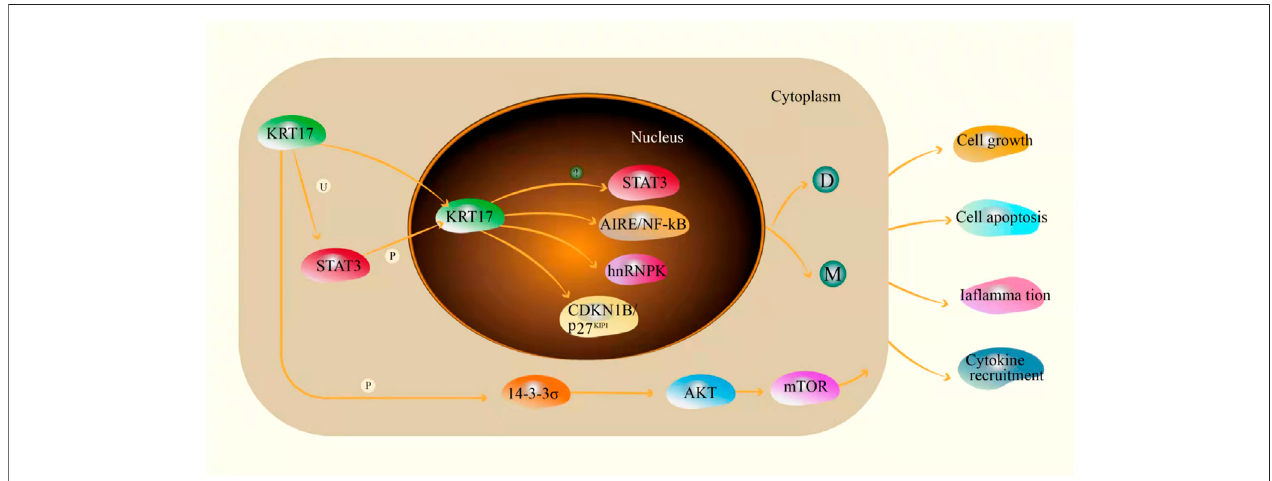
FIGURE 2 | The mechanism of KRT17 in cells(U: ubiquitin; P: phosphorylated; D: degradation; M: mature fully polymerized keratin fi laments; ?: